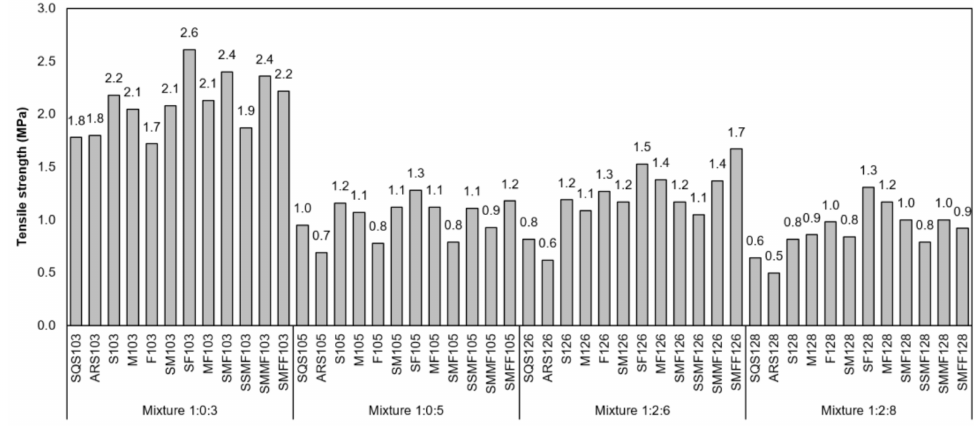
Figure 10. Tensile strength of the